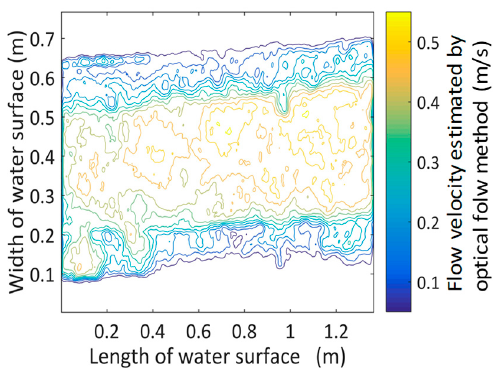
Figure 6. Time-averaged SVWF distribution.